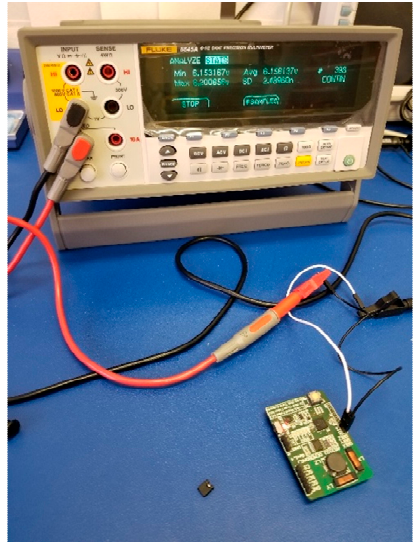
Table 1. The relation of distance between receiver and transmitter, the current of the receiver, and the working duration of the receiver.